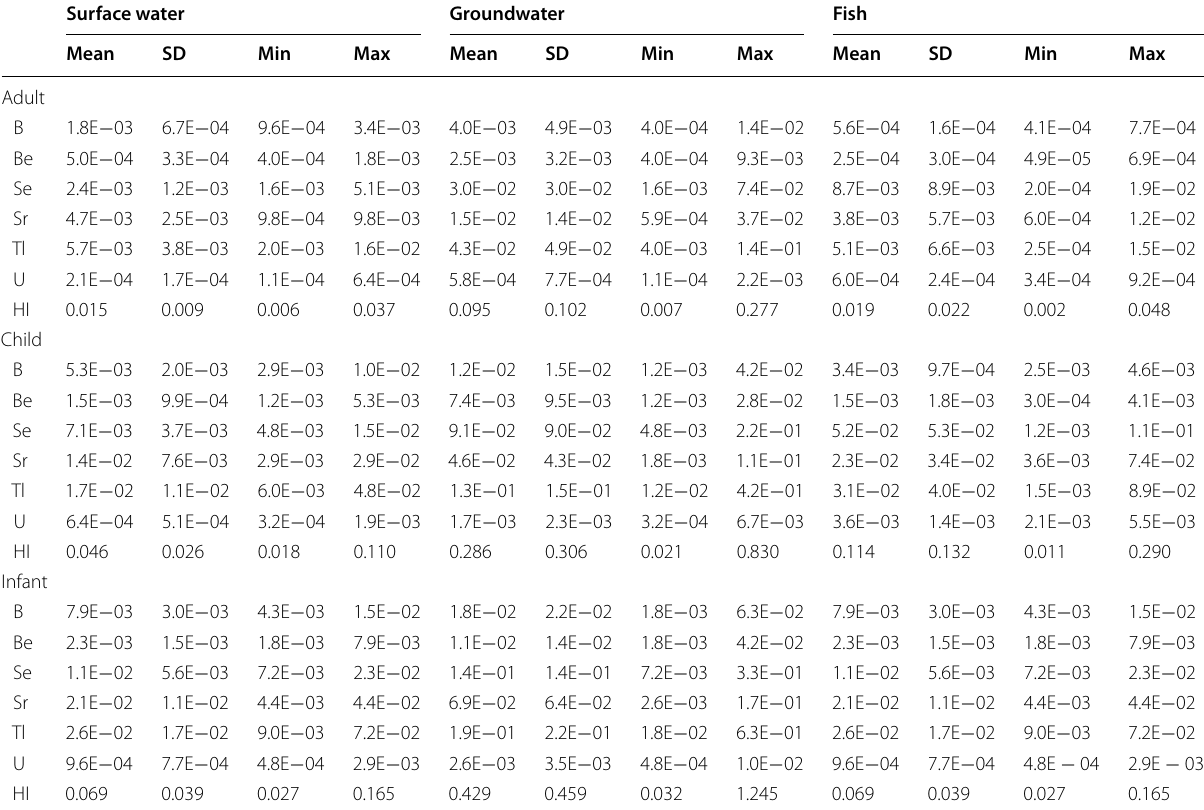
Table 4 Non-cancer hazard quotient (HQ) and hazard index (HI) values of elements in water and fish samples Surface